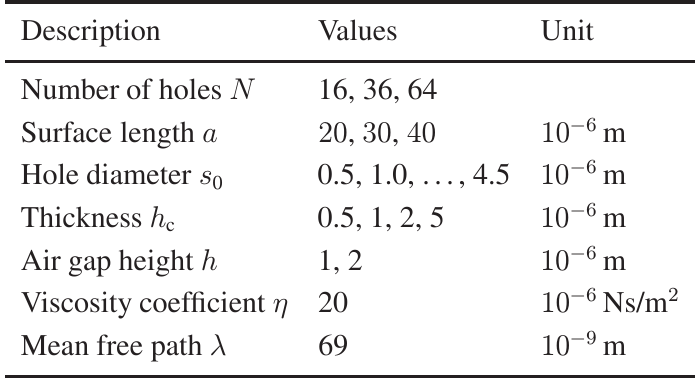
Table 1 . Parameters for the simulated dampers. Altogether, 504 different topologies were generated and